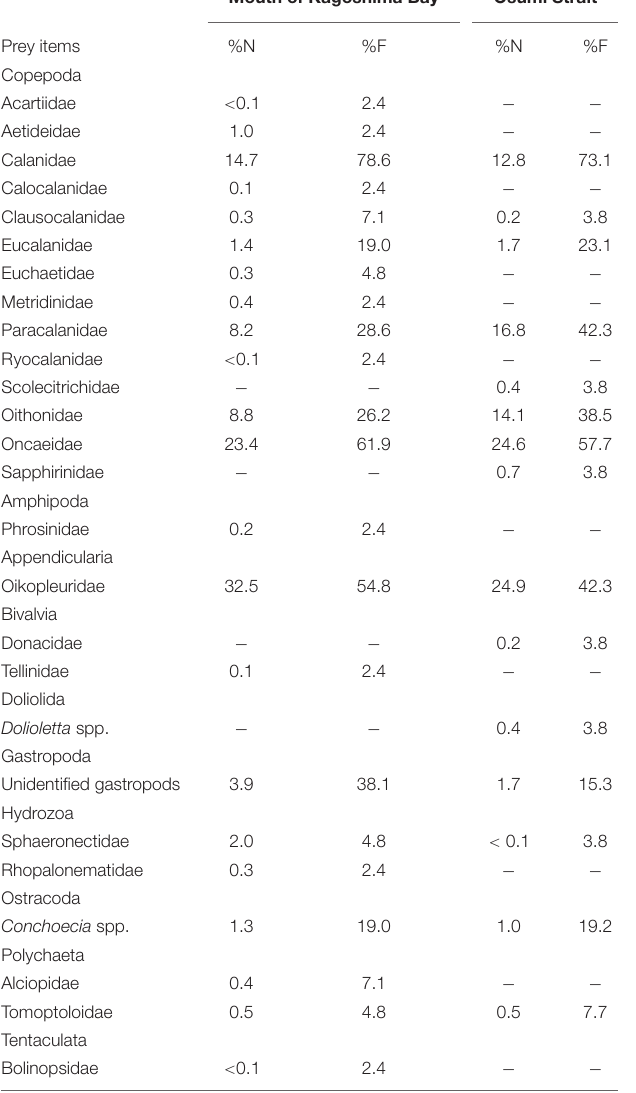
TABLE 4 | Taxonomic percentages of sequence reads (%N and%F) in gut contents of Scomber japonicus larvae. Mouth of Kagoshima Bay Osumi Strait